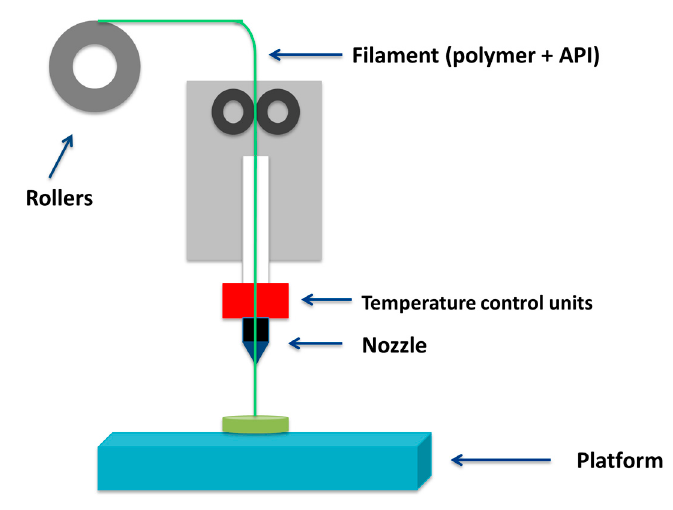
Figure 3. Fused deposition modelling ( FDM) Printing system.